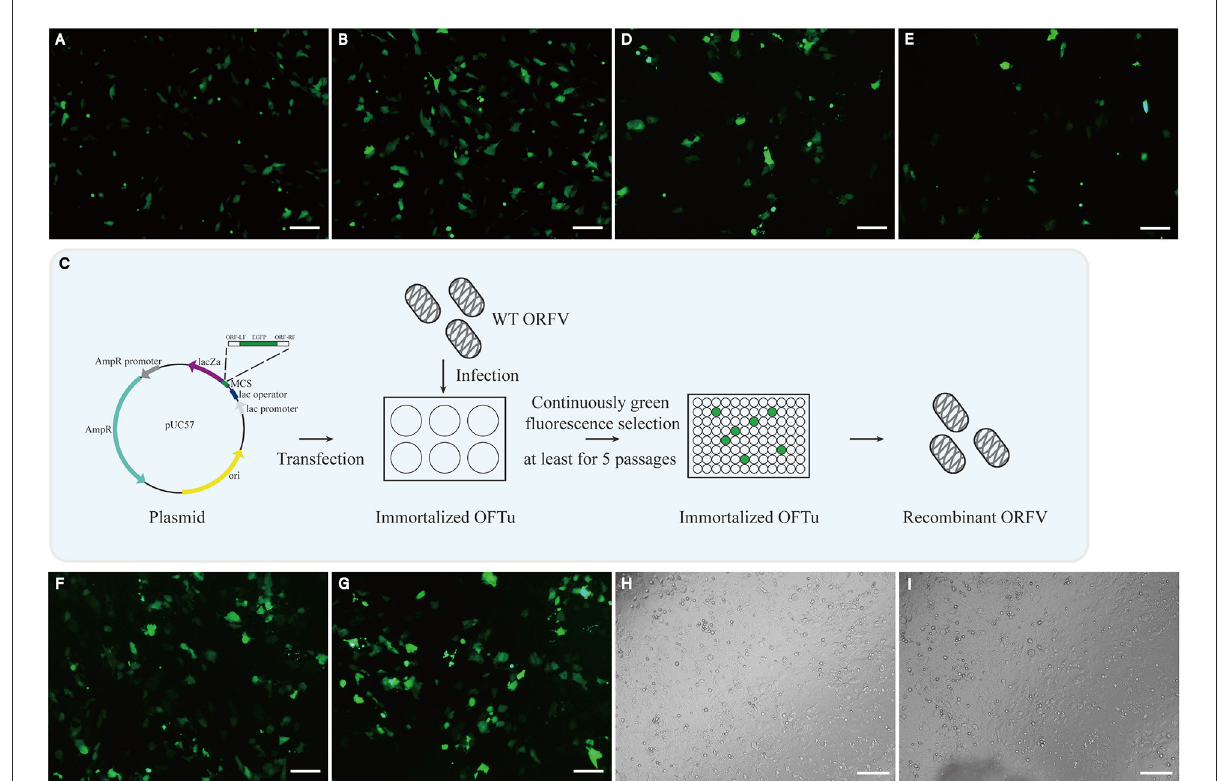
FIGURE6 Immortalized OFTu cell line can generate and amplify recombinant ORFVs. Primary OFTu (A) and immortalized OFTu cell (B) under a fluorescence microscope 48h after pEGFP-C3 transfection. Scale bar = 100 µ m (C) Schematic overview to generate recombinant ORFV. Immortalized OFTu (D) and primary OFTu (E) produce GFP-positive recombinant viruses at 48h.p.i. Immortalized OFTu (F) and primary OFTu (G) produce ORFV recombinant. Scale bar = 100 µ m. Recombinant ORFV causes CPE in immortalized OFTu cells (H) and primary OFTu cells (I) . Scale bar = 100 µ